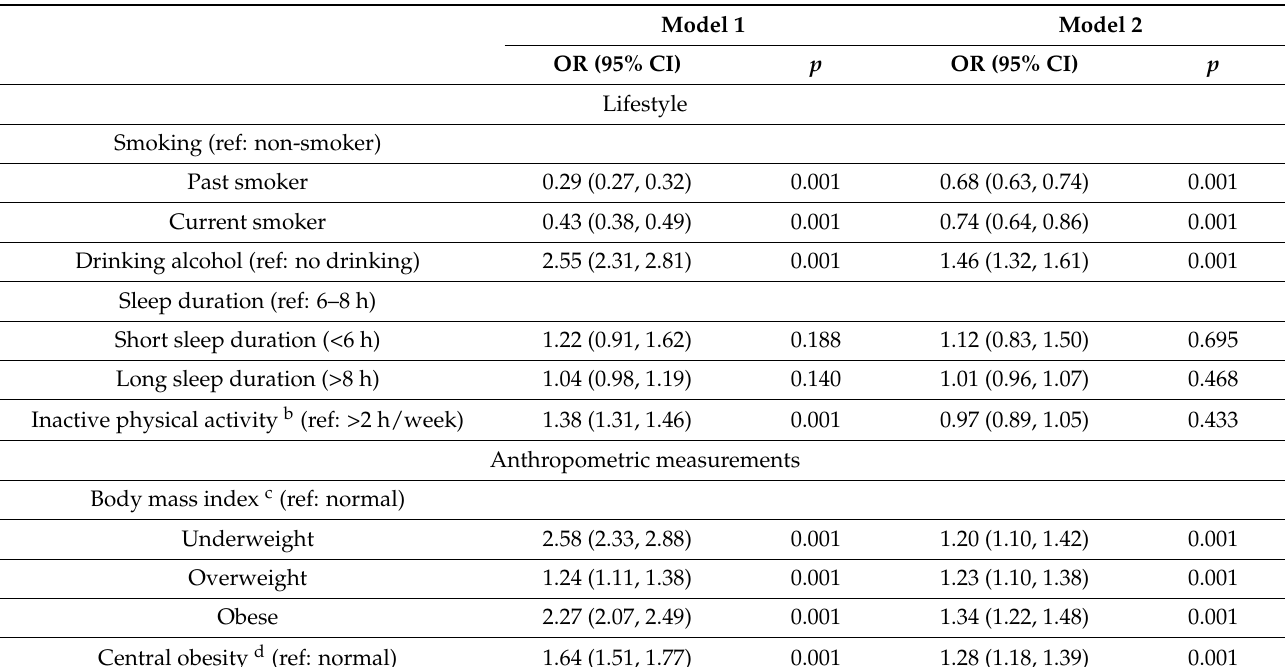
Table 2. Odds ratios and 95% confidence intervals for the associations between lifestyle, anthropometric variables, and anemia a .